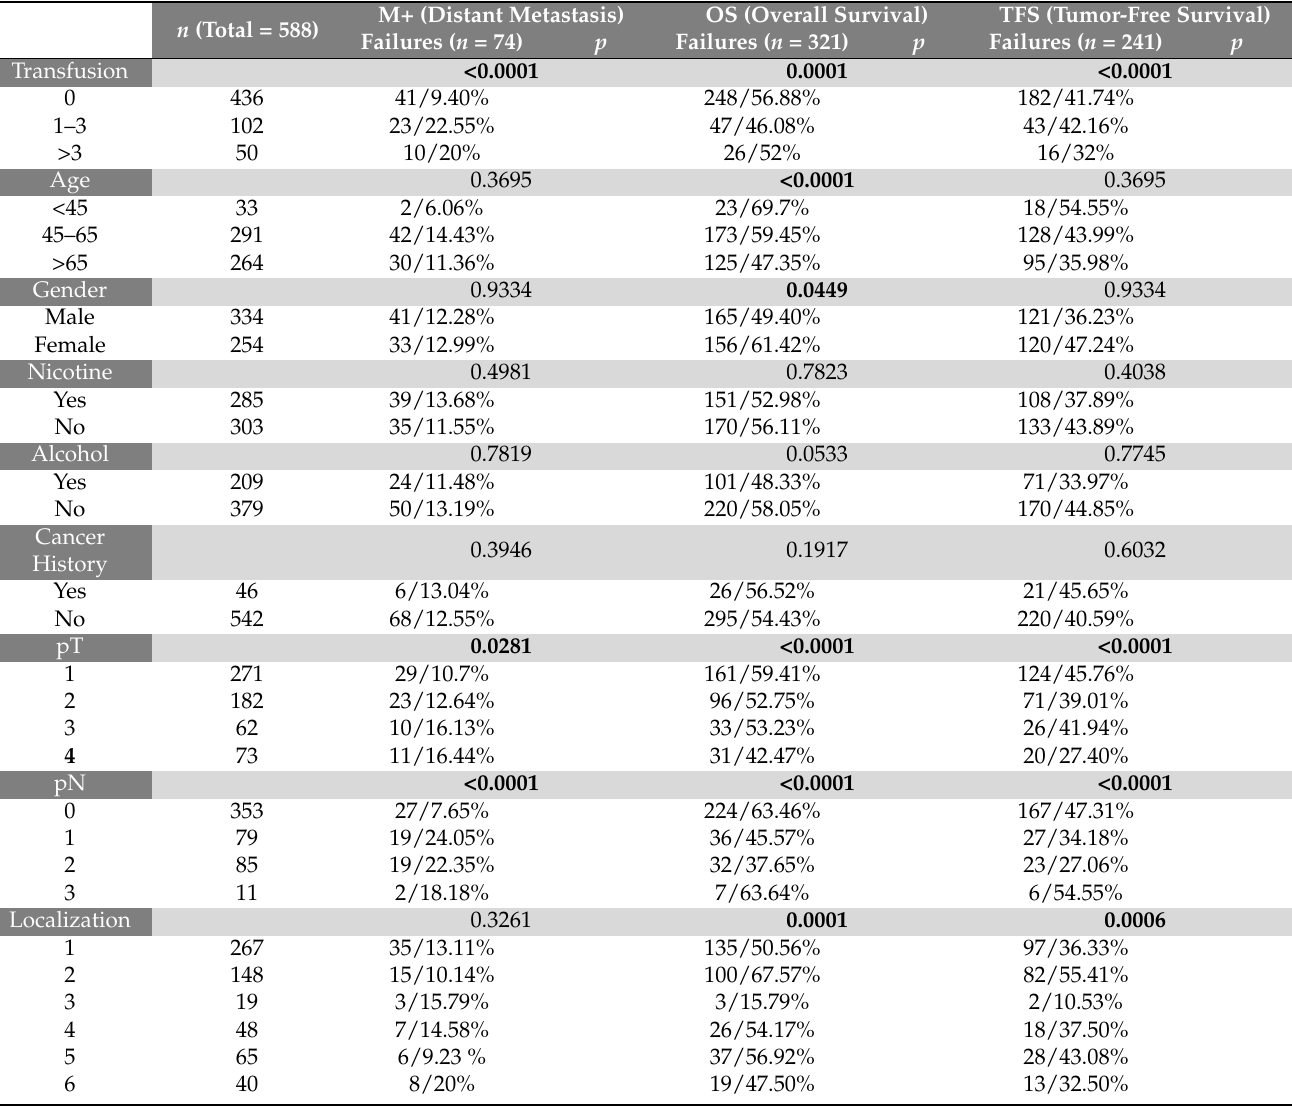
Table 2. Univariate Cox regression analysis on the frequency of patient specific factors in correlation to M+, OS and